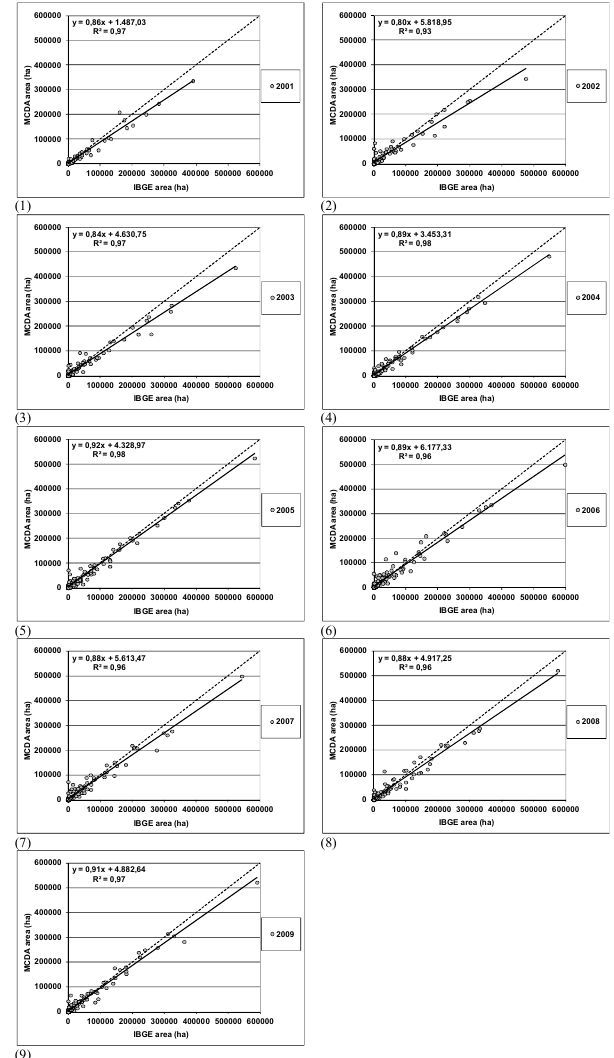
Figure 4. Regression analysis between soybean area estimates by MCDA (2 nd forecast) and IBGE, for Mato Grosso state for the crop years 2000/01 to